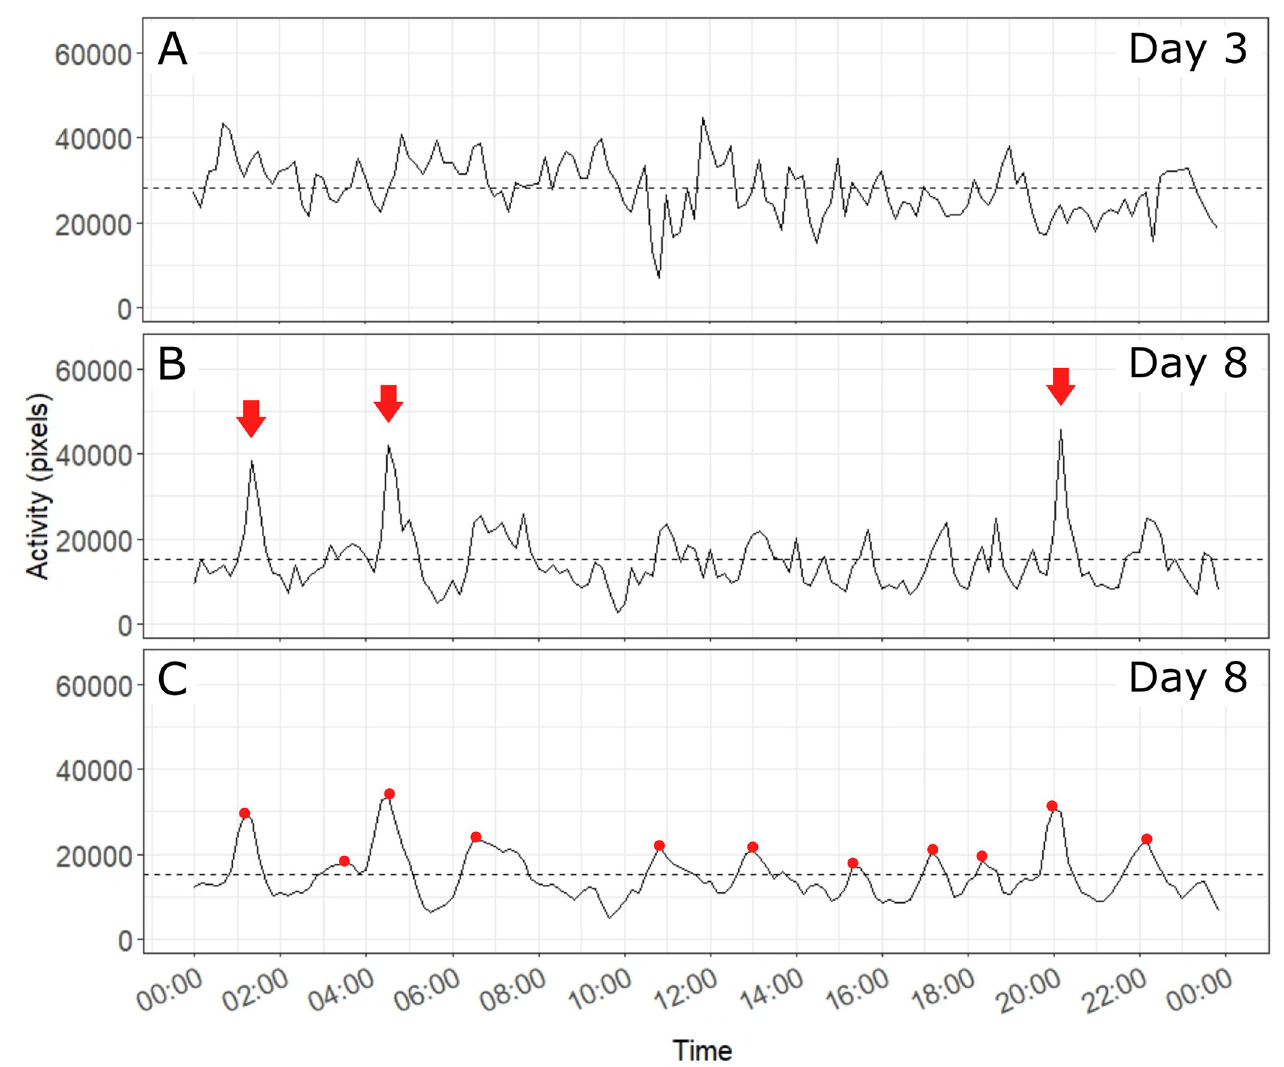
Fig 4. Examples of activity patterns. Fig 4A and 4B shows the activity signals of colony 7 recorded respectively on day 3 (satiation phase) and day 8 (starvation phase). Fig 4C represent the activity patterns of colony 7 on day 8 with smoothed signal. The dashed lines correspond to the daily activity index, i.e., the average of all the activity measures made on a day. The red arrows point to clear-cut activity bursts emerging when the colonies were starved. The red dots in Fig 4C show the peaks that were detected by the analysis described in the method section.